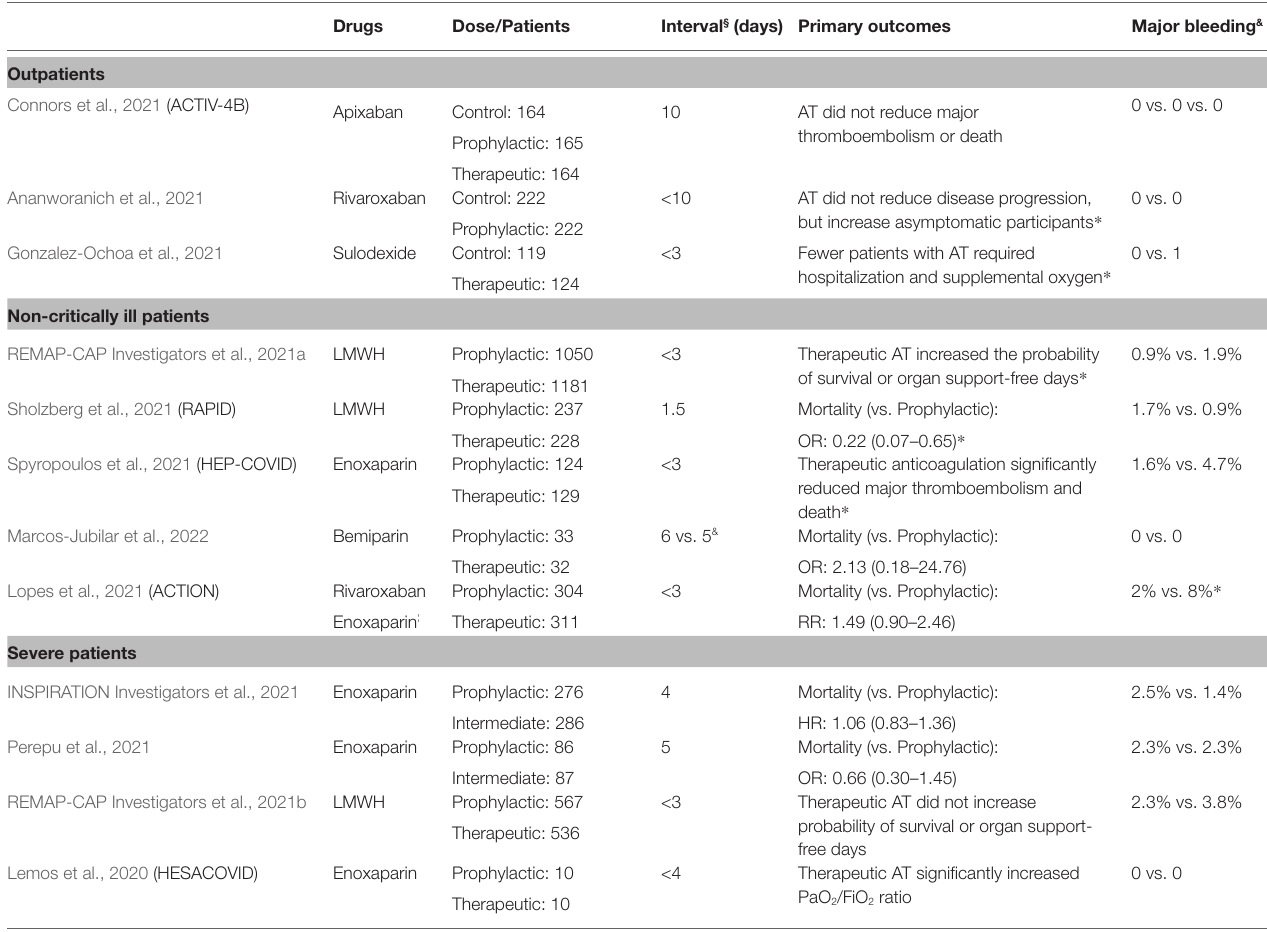
TABLE 1 | Randomized clinical trials of anticoagulant therapy in COVID-19